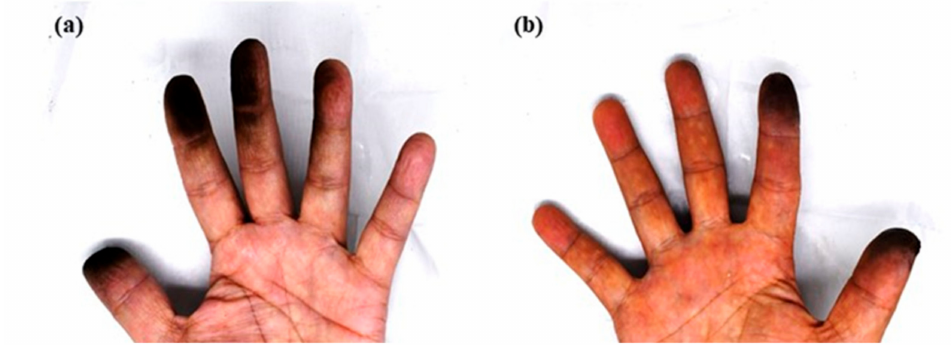
Figure 4. After operating 190 fragments for the asexual propagation of S. flexibilis , ( a ) the left hand and ( b ) the right hand became